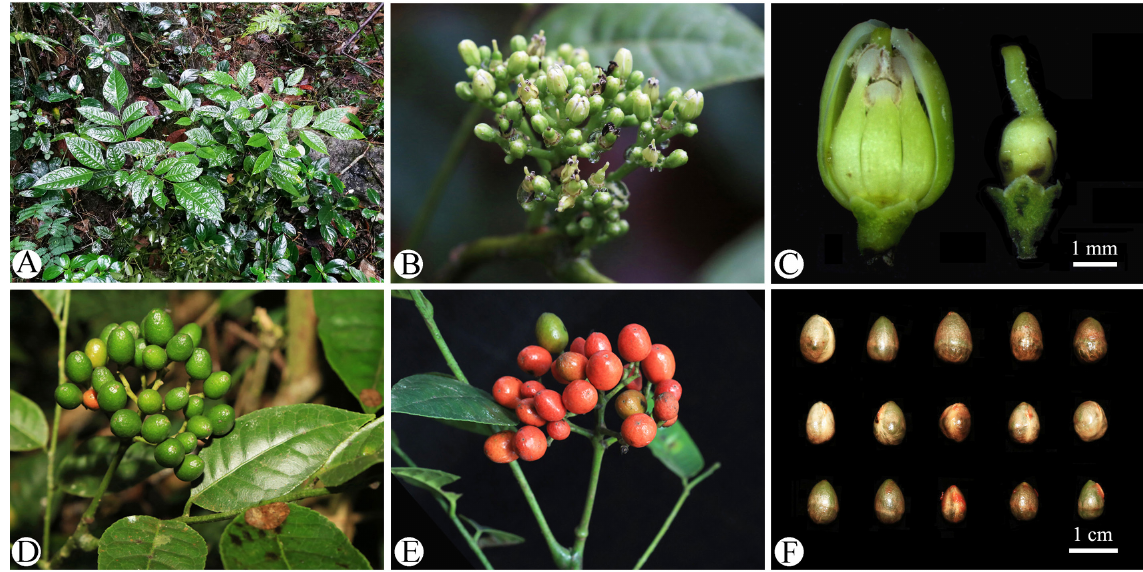
Fig. 9. Bergera macrophylla (C.C.Huang) F.J.Mou comb. nov. A. Plants. B . Inflorescence. C . Flower and pistil. D–E . Infructescence. F . Seeds. Photos taken by Feng-Juan Mou in